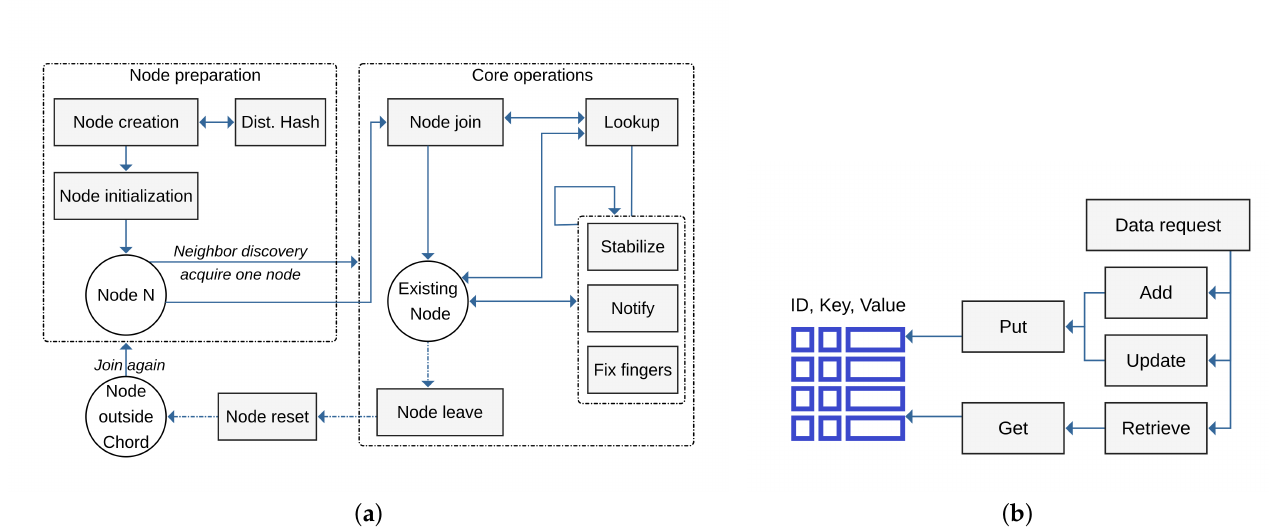
Figure 4. ( a ) Node management operational architecture. ( b ) Data management operational